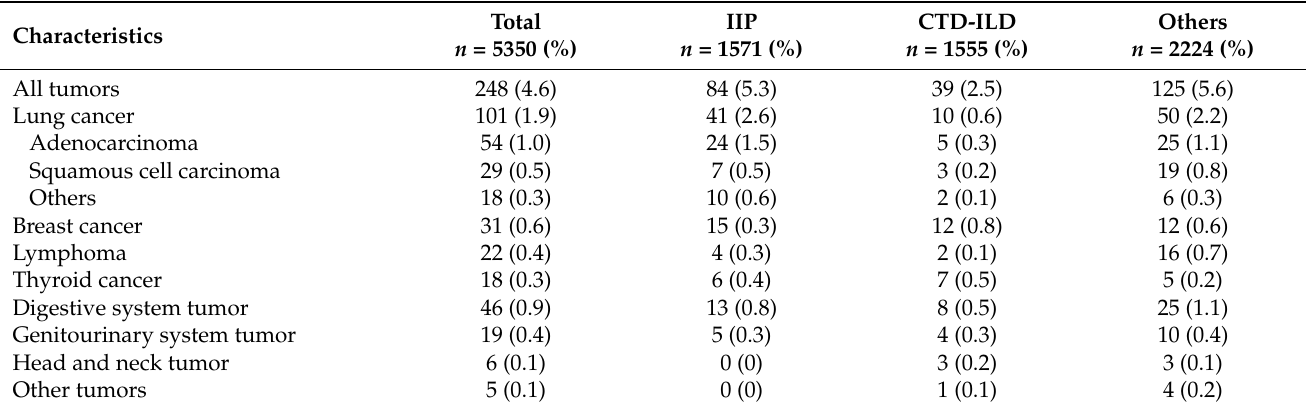
disease-associated ILD.